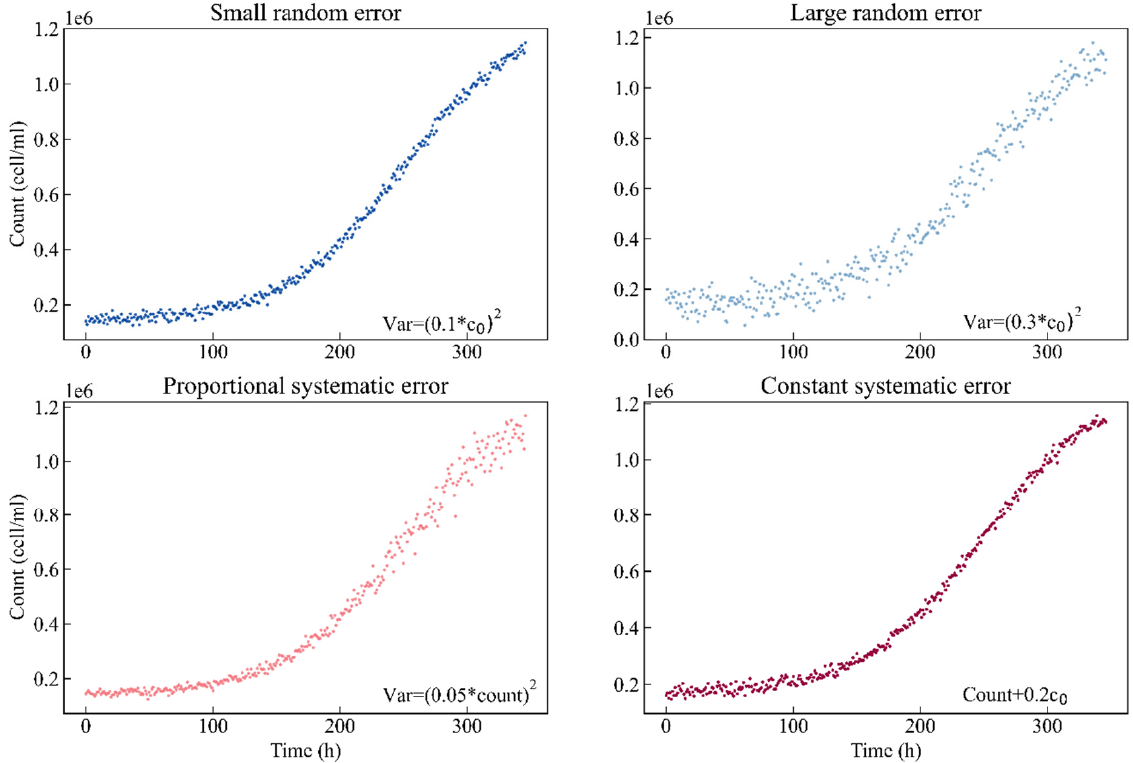
Figure 1. Simulated curves of the different error types. Blue: small random error ( σ = 0.1c 0 ); sky blue: large random error ( σ = 0.3c 0 ); red: proportional systematic error ( σ = 0.05count); magenta: constant systematic error ( σ = count + 0.2c 0 ).